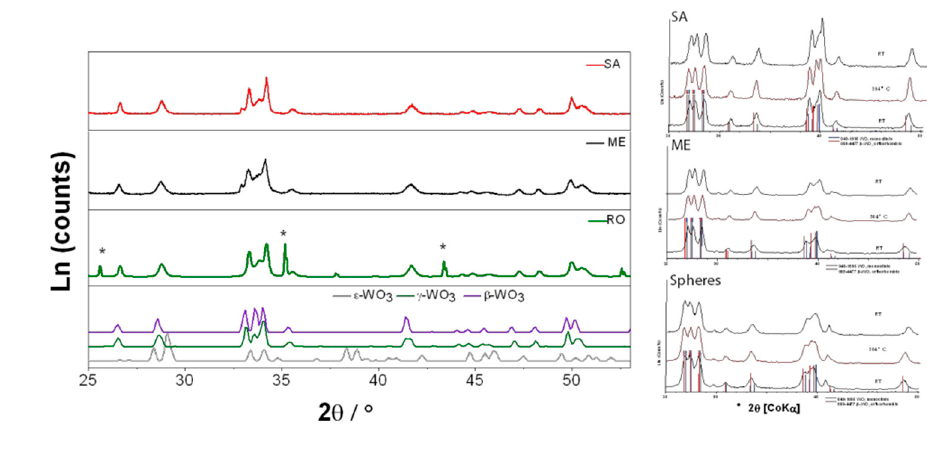
Figure 2. Left The XRD patterns of the sensitive layer at room temperature (the peaks labeled with a * are attributed to Al 2 O 3